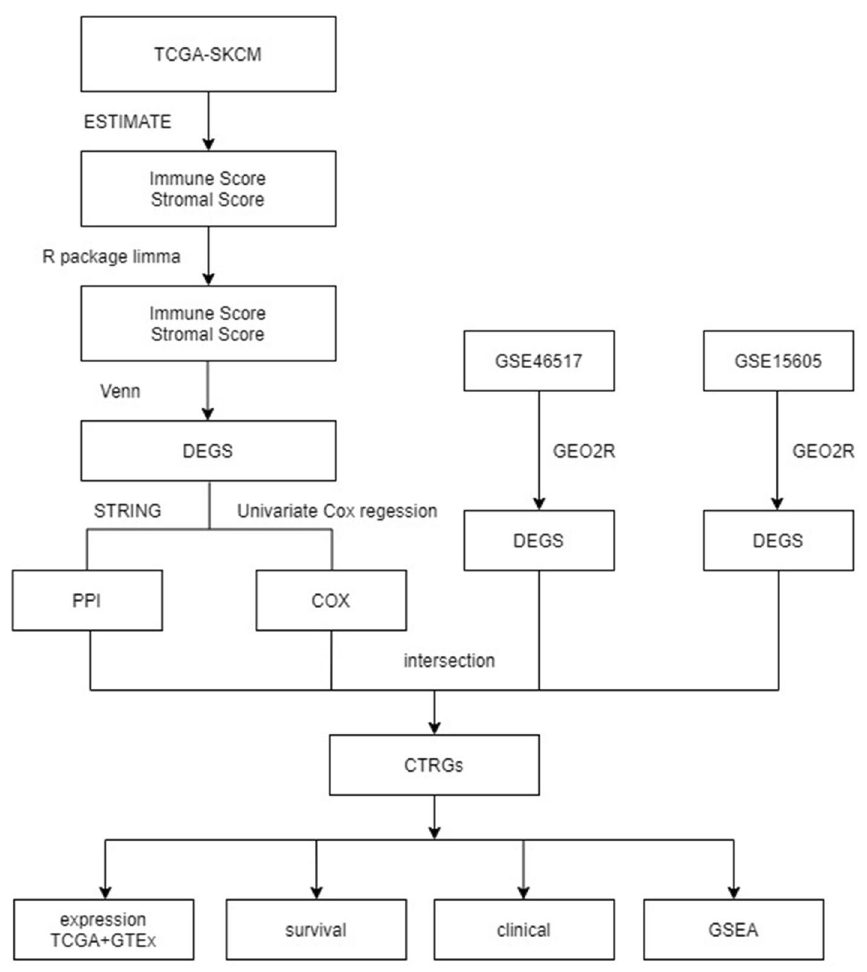
Figure 1. Flowchart of this